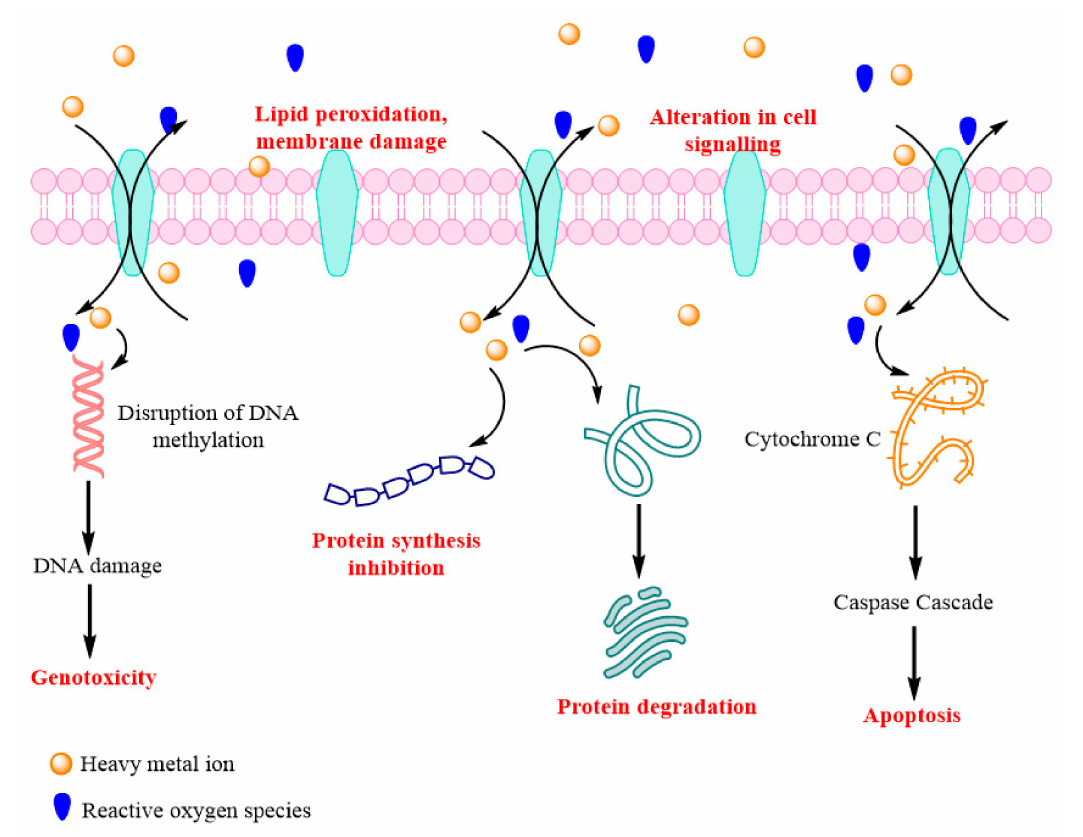
Figure 4. Mechanism of heavy metal toxicity at the cellular